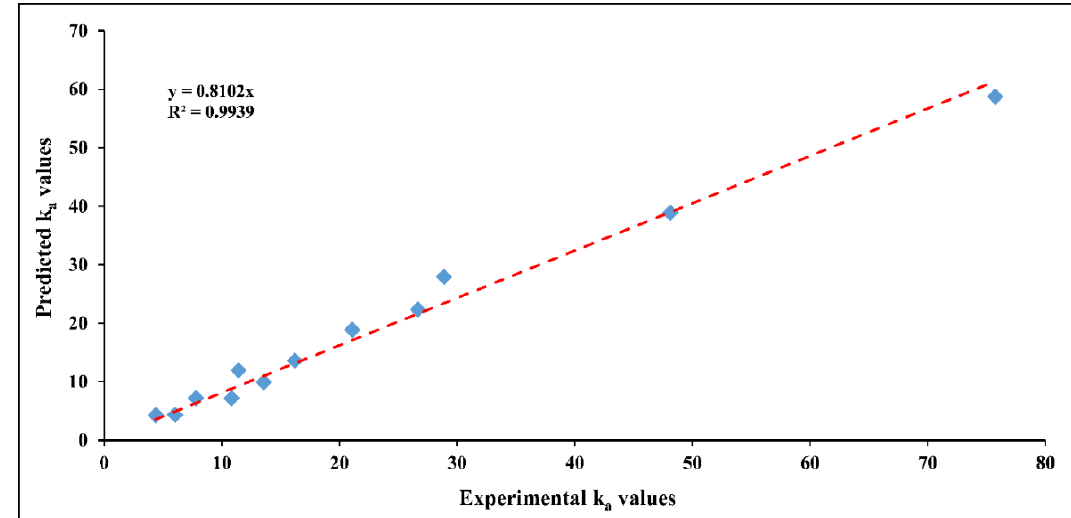
Figure 11. A comparison between experimental and predicted ( k a 𝑥 10 3 ) values for different operating conditions.